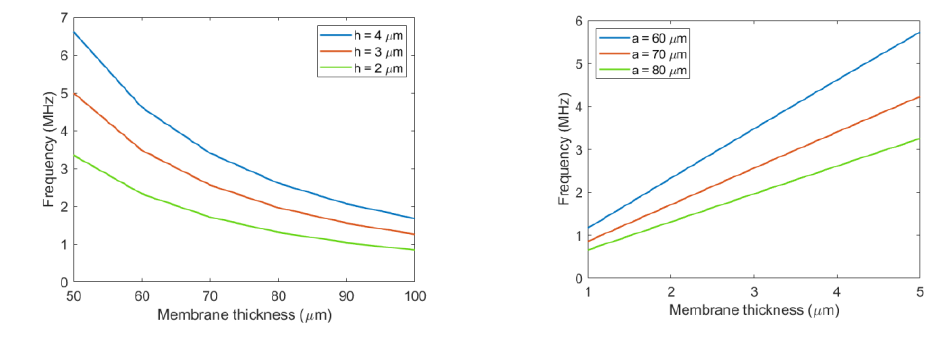
Figure 6. Frequency variation with membrane radius and membrane thickness.